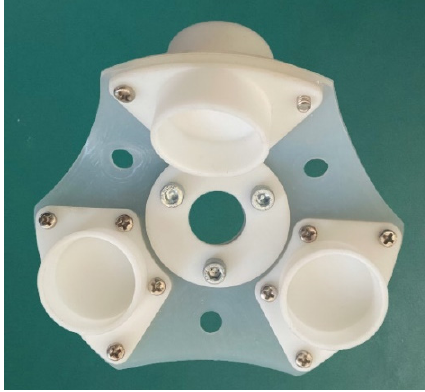
Figure 2. Photo of the novel flexible connecting plate.